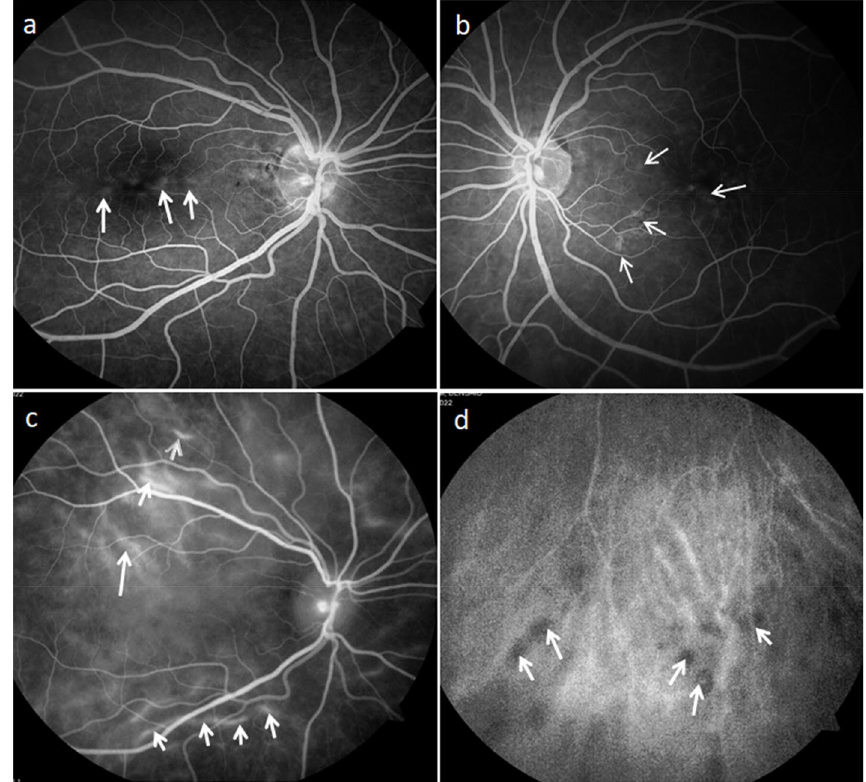
Fig. 3 a , b : FFA (fundus fluorescein angiography) photos showing pinpoint leakage at the posterior pole of both eyes (arrows). c : ICG (indocyanine green angiography) of right eye showing hypercyanescence of the stromal choroidal vessels (arrows). d : ICG of the peripheral retina of left eye with multiple hypocyanescent dark dots (arrows) at the